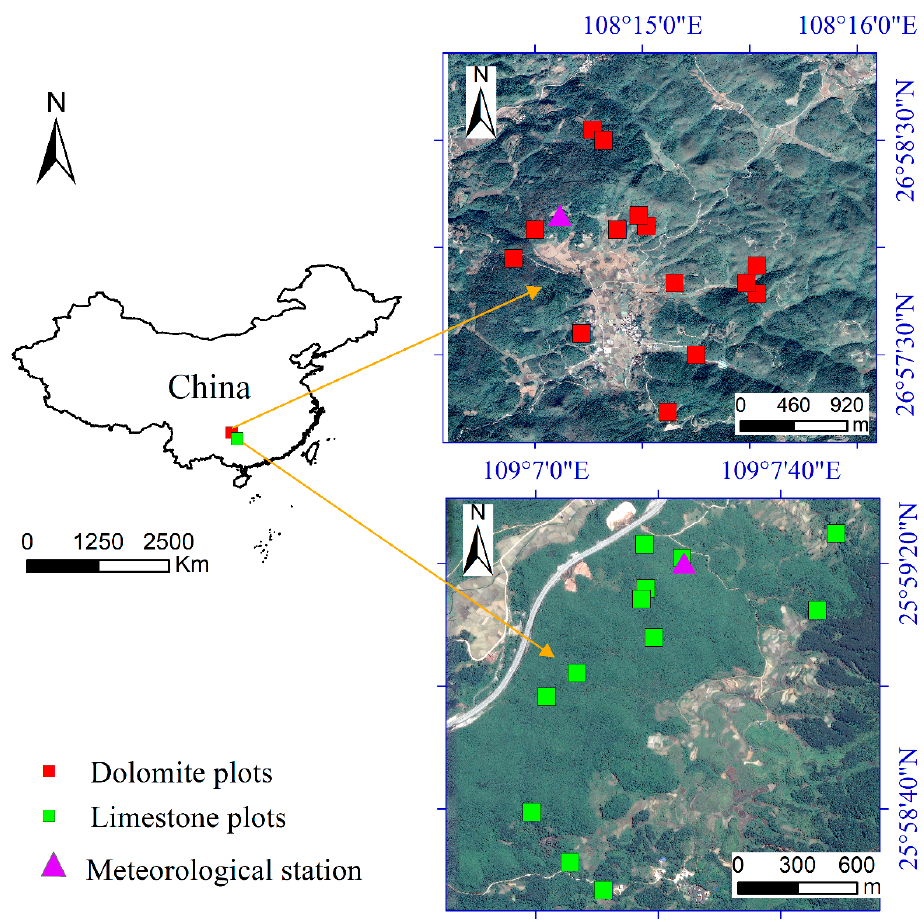
Figure 1. The locations of dolomite and limestone karst-forest plots in Guizhou Province, Southwest China.